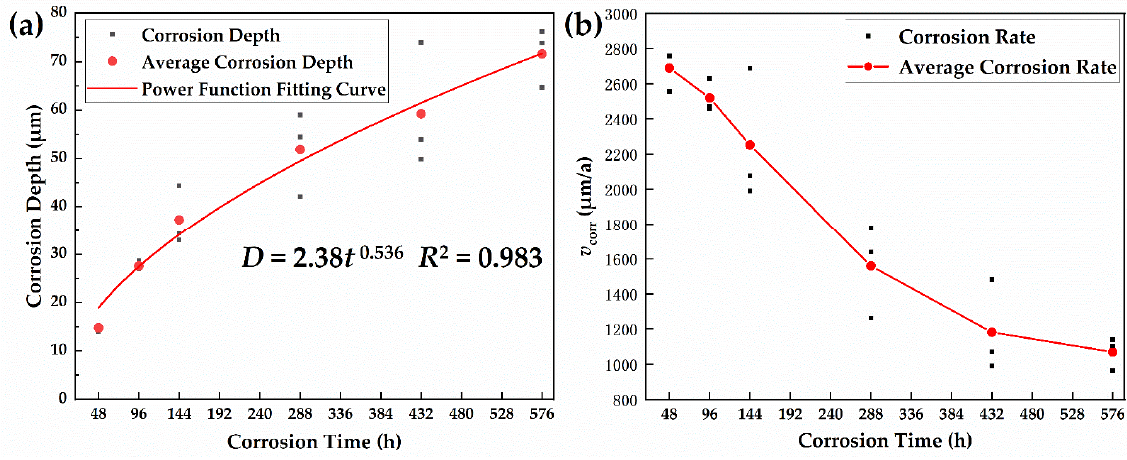
Figure 2. Corrosion Kinect analysis after a 576-h alternate immersion test: ( a ) calculated corrosion depth; ( b ) corrosion rate. Table 3. Environmental factor data of the Wanning Outdoor Exposure Test Station.